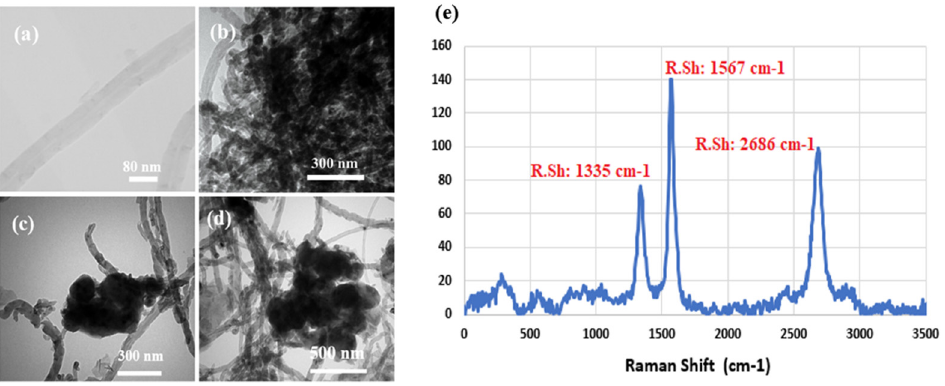
Figure 5. TEM micrographs of ( a ) CNTs, ( b – d ) MZ/CNTs powders and ( e ) Raman spectra of pure CNTs.